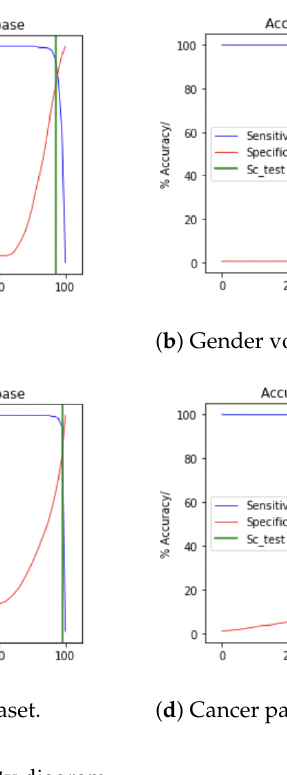
Figure 22. Sensitivity vs. specificity